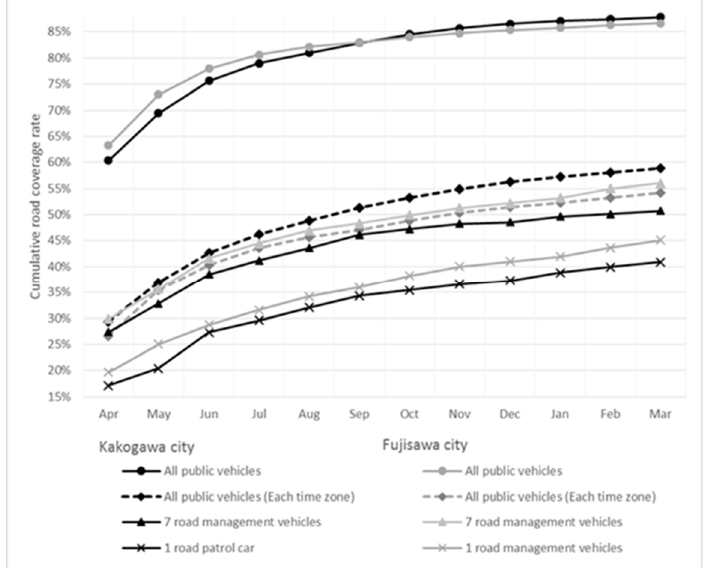
Figure 3. Difference in cumulative road coverage rates by the number of vehicles. The number of all public vehicles: Kakogawa city: 171, Fujisawa city: 128, road management vehicles: 7, road patrol cars: 1.